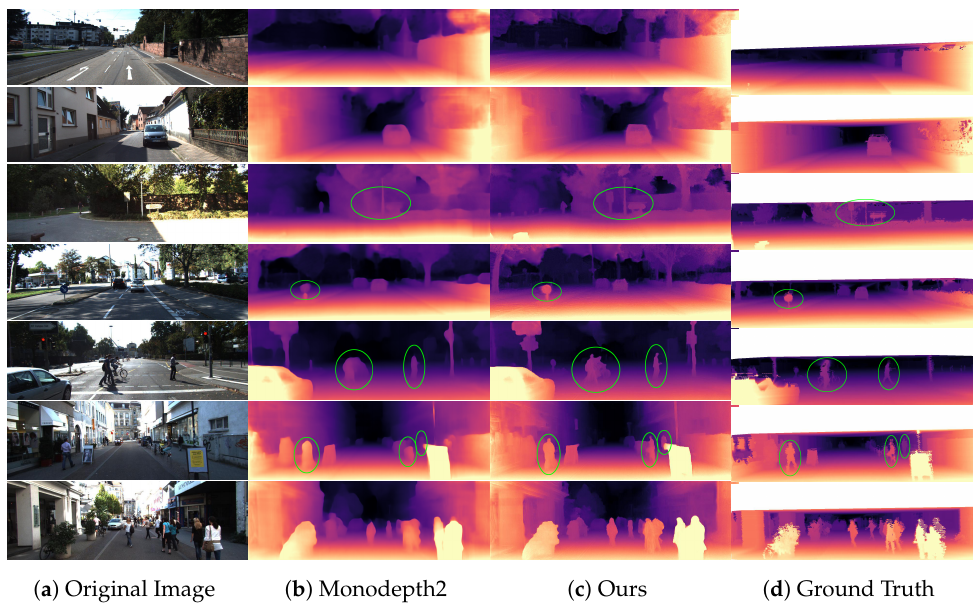
Figure 6. Qualitative comparison our approach with state-of-the-art methods on frames from the KITTI data set. Our model proced better performance in low-texture areas, predicted sharper edges, and retained more spatial information. Note that the ground truth, Velodyne depth, being very sparse, we interpolated it for visualization purposes.